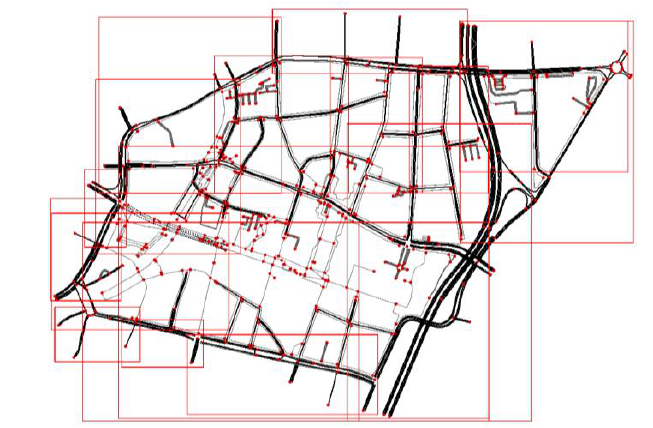
Figure 4. Traffic Assignment Zone (TAZ) distribution of Duisburg inner ring; each red box shows the roads in one TAZ.